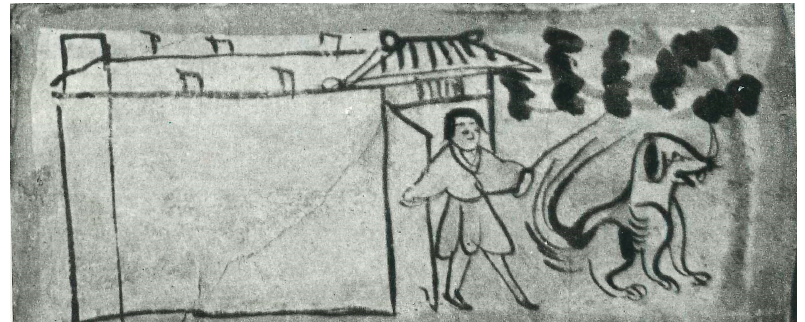
Figure 6. Citadel with guard and dog, east wall of front chamber, Xincheng M5, painting on brick, Wei-Jin period (220–317). (Gansusheng Bowuguan et al. 1985, pl. 54.2). ©Wenwu Press. This figure